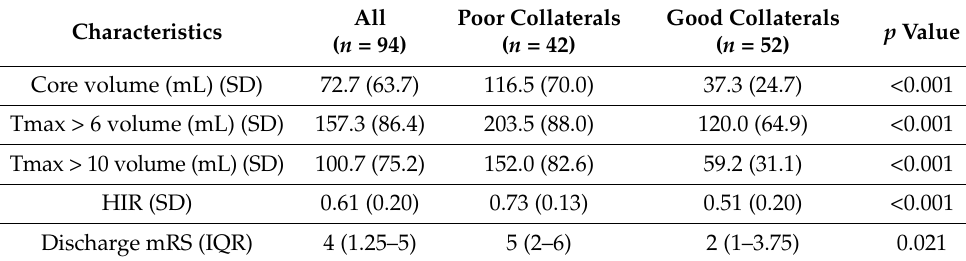
Table 2. Core volume, Tmax > 6- and 10-s lesion volume, hypoperfusion index ratio (HIR) and modified Rankin scale (mRS) at discharge in patients with poor collaterals (score 0–3) and good collaterals (score 4–5) based on the multiphase CT angiography collateral